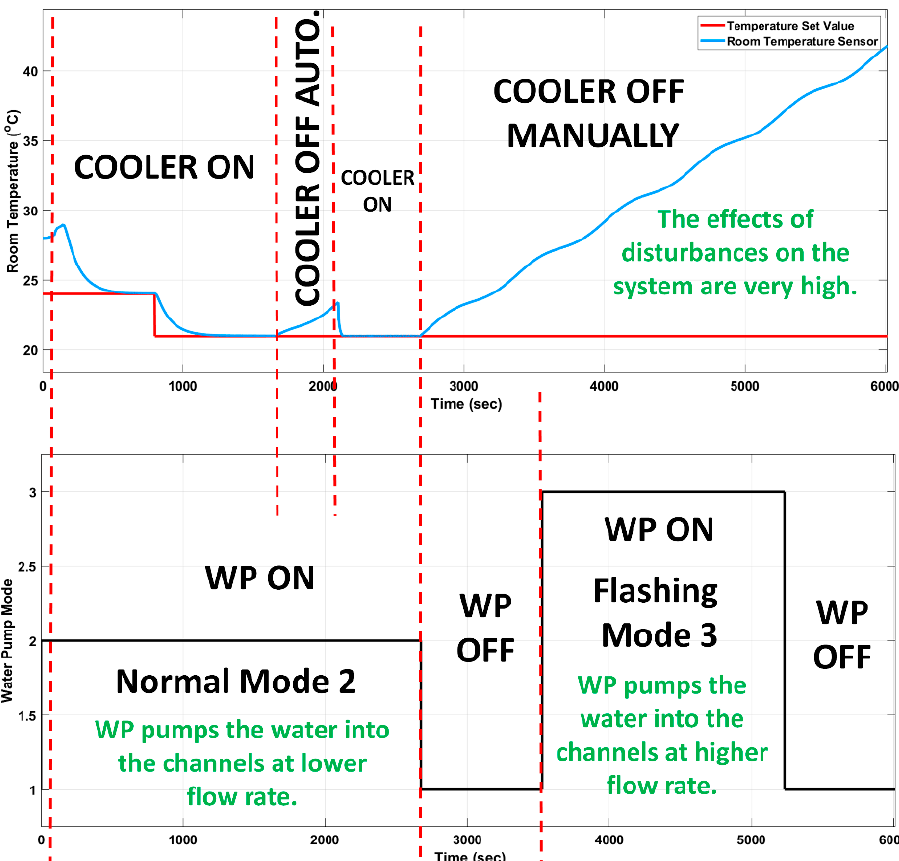
Figure 7. The room temperature control performance and variation of the water pump operation mode.